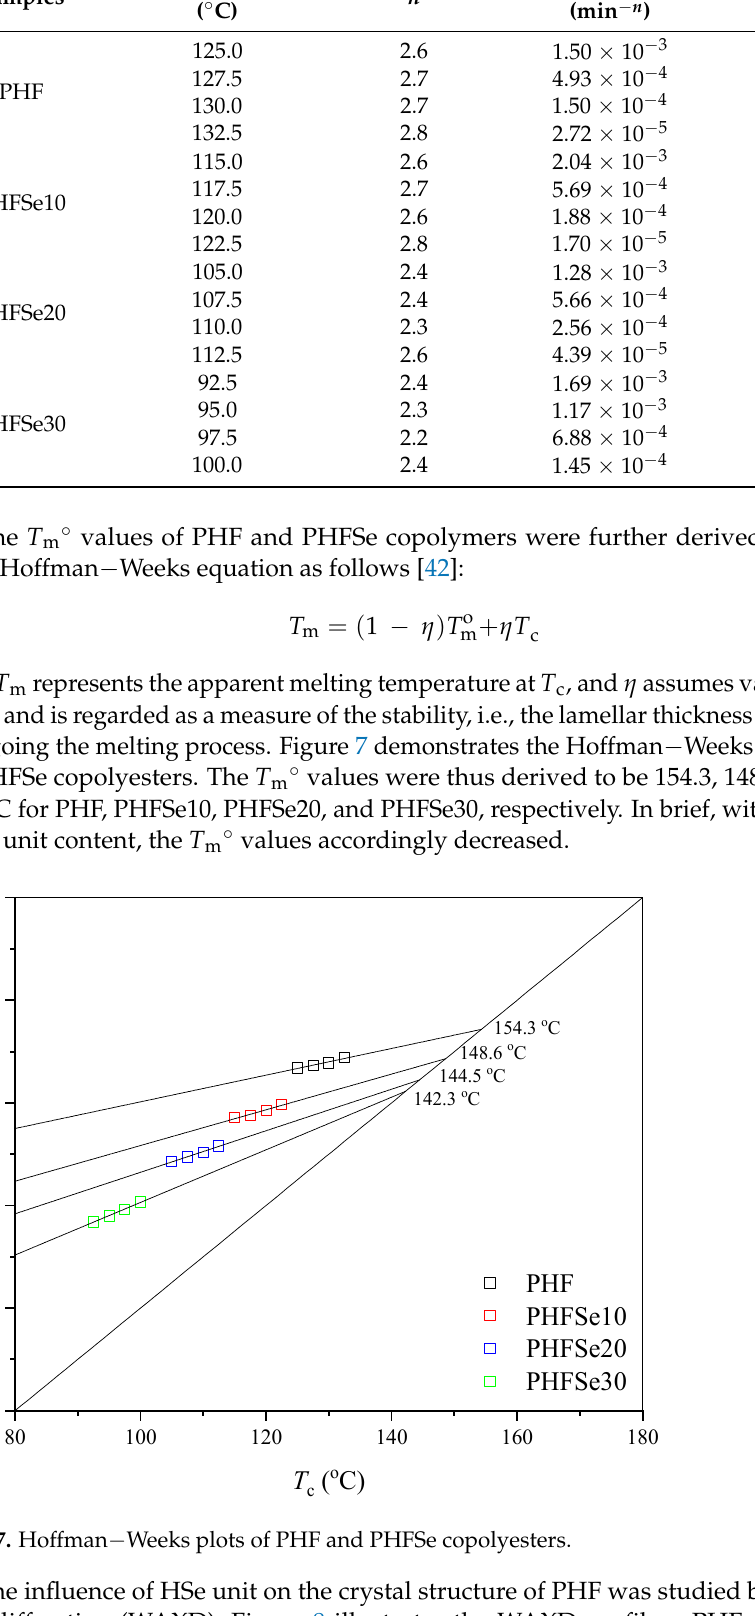
Table 3. Summary of the Avrami parameters for PHF and PHFSe copolyesters. Samples